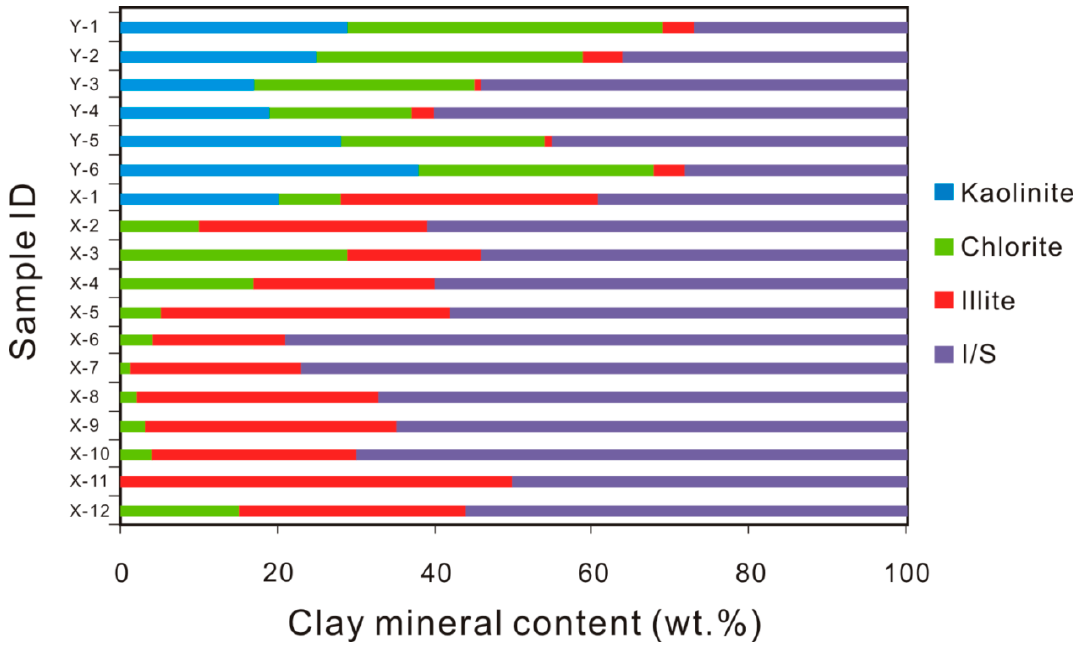
Figure 5. Clay mineral composition of transitional Longtan Shale samples from YV-1 and XD-1.